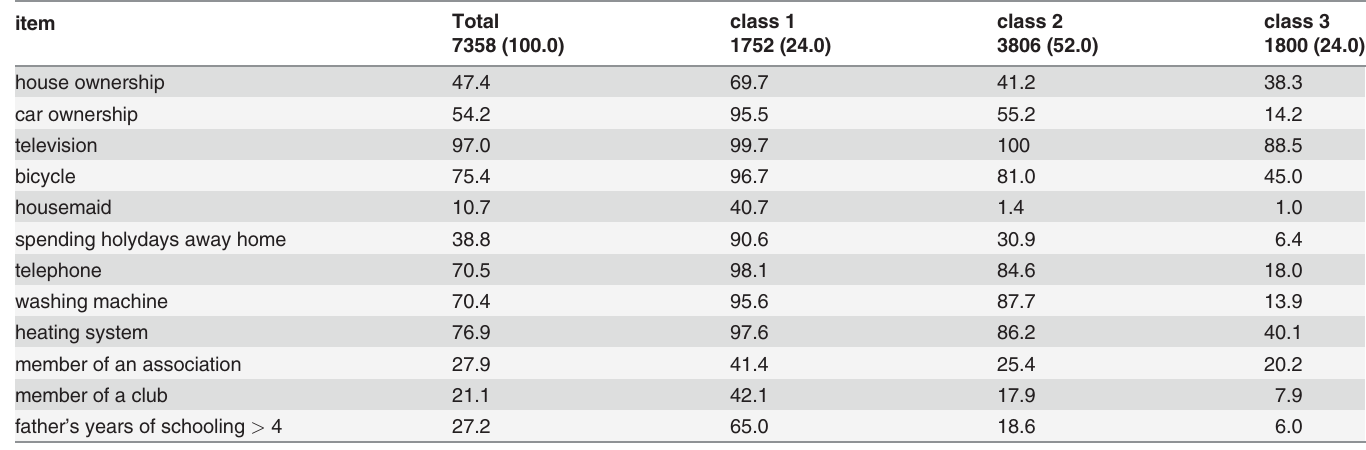
twelve items used to characterize past socioeconomic circumstances, we used full information maximum likelihood estimation to handle missing values, assuming missing at random. [44] The proportion of missing values in each of twelve items varied between less than 1% and 20%. Sensitivity analyses allowed us to evaluate the effect of missing data on LCA by excluding from the LCA the items with more than 15% of missing data (heating system at home, television and father ’ s years of schooling > 4). The agreement between a model with 12 items and the model with only 9 items was analyzed by using Cohen´s Kappa Statistics, which value (kappa = 0.85) provides some assurance against substantial bias in the LCA. [45] Multiple Poisson regression with robust variance was used to estimate adjusted risk ratio (RR) and respective 95% confidence interval (95% CI). Given cesarean is a common event in our setting (35% of all deliveries), this approach was preferred to logistic regression in order to avoid overestimation of measures of association. [46] Poisson regression analyses were stratified by the three categories of past obstetric history (primiparous, multiparous with no previous cesarean and multiparous with previous cesarean). A basic model with SEP-12 was fitted on mode of delivery and covariates were introduced in the model based on a conceptual framework with three levels of determination defined accord- ing to temporal relationships between variables. [47] The first level included maternal charac- teristics that could be identified at beginning of pregnancy: maternal age, chronic diseases, maternal body mass index, and current socioeconomic indicators (education level and house- hold income per month). The second level incorporated variables associated with pregnancy Table 2. Marginal percentage of subjects with positive answer to the item in each assigned class of the 3-classes latent class